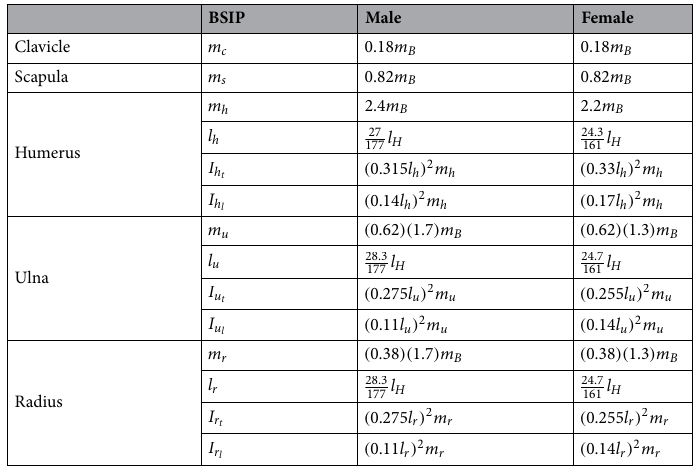
Table 1. Scaling BSIP based on subject’s gender, weight ( m B ), and height ( l H ) using the 3D predictive equations of 38 . Clavicle, scapula, humerus, ulna, and radius masses are denoted by m c , m s , m h , m u , and m r , respectively. The segments lengths of humerus, ulna, and radius are l h , l u , and l r . Their inertias in transverse and lateral directions of their bone-fixed frames are denoted by I h m u and m r are defined as 62% and 38% of the forearm weight. The m B and l H are expressed in centigram and centimeter,